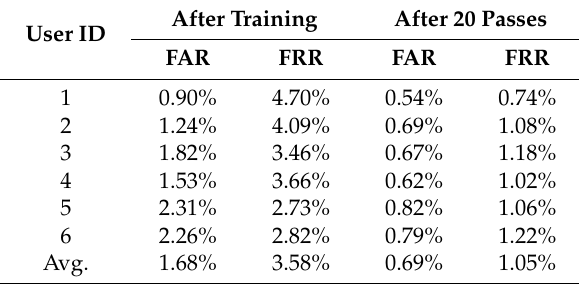
Figure 17. User #1’s perspective of experiments.